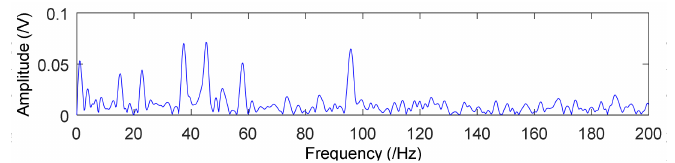
Figure 12. Diagonal slice spectrum of noisy signal.